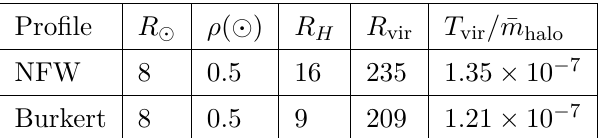
Table 1 . Parameters of CDM distributions, which dominate the gravitational potential of the Milky Way. All distances in kpc, ρ in GeV/cm 3 . ¯ m sub-population of the halo, such as the MTH mirror